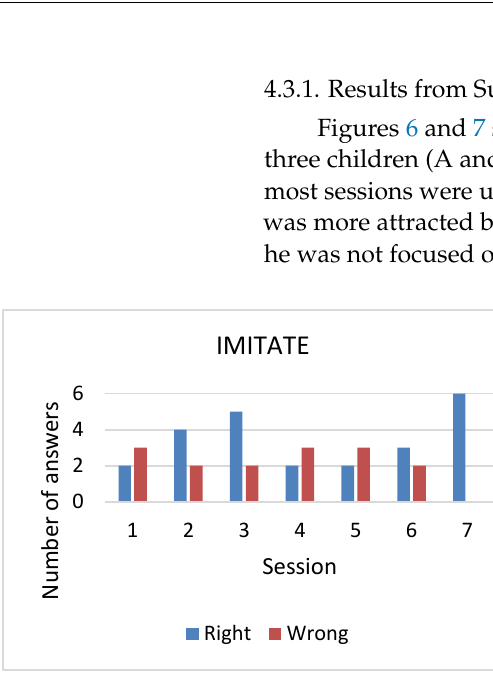
Figure 5. Experimental configuration: Child – ZECA – Professional – Researcher.